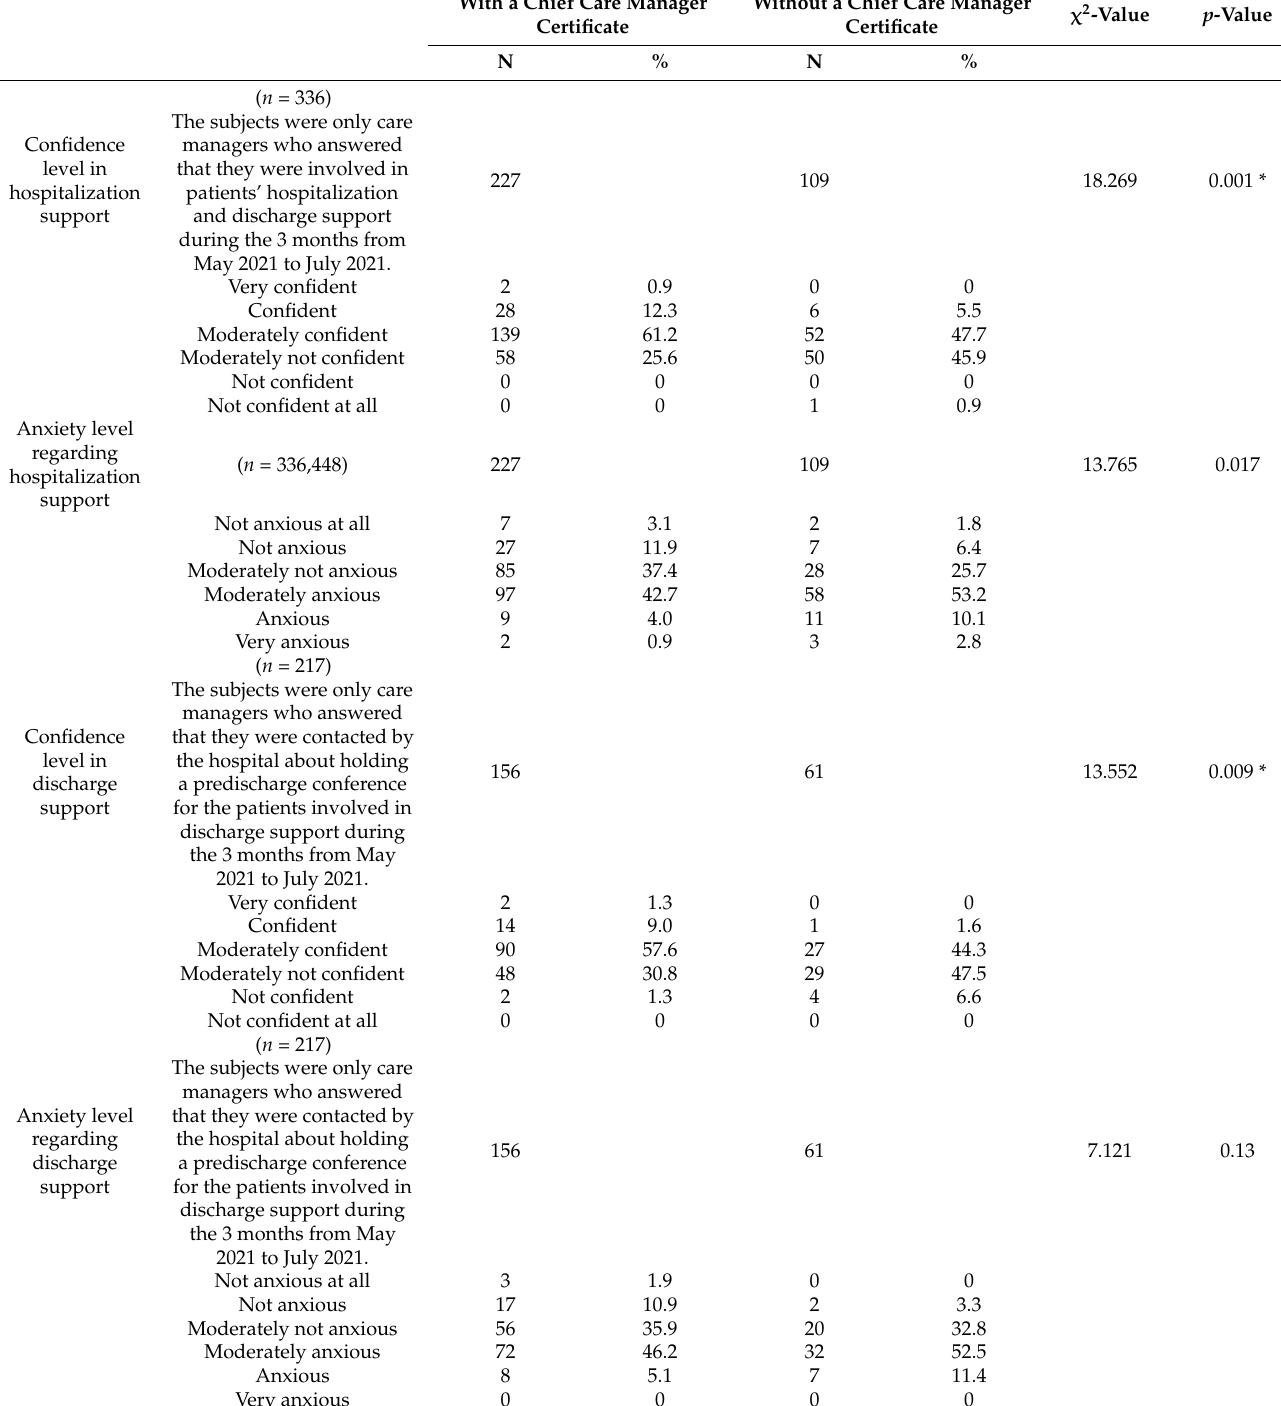
Table 3. Degrees of confidence and anxiety in hospitalization/discharge